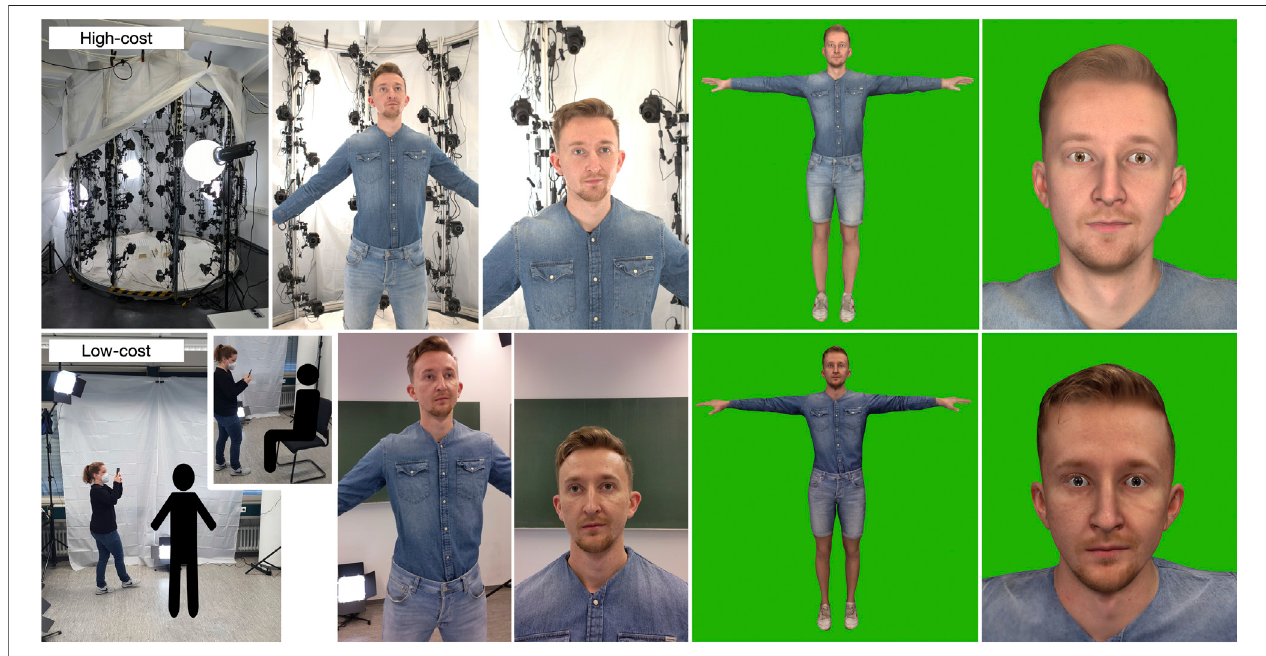
FIGURE 1 | The high-cost (top) and the low-cost (bottom) scan process.